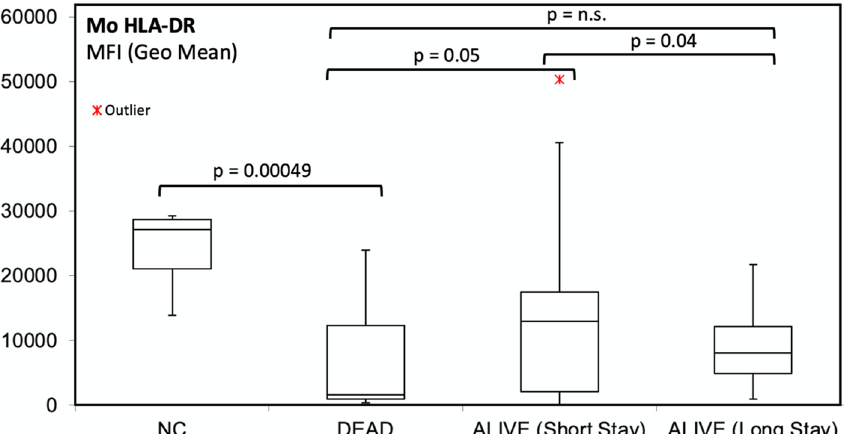
Fig. 3 Expression of monocyte HLA-DR as an indicator of immune competence in SARS-CoV2 infected patients. The lowest level of expression was observed in patients who died for multiple complications, whereas patients with prolonged hospital stay showed a lower HLA-DR expression level, as compared with patients with shorter and more favorable clinical course and normal control (NC)